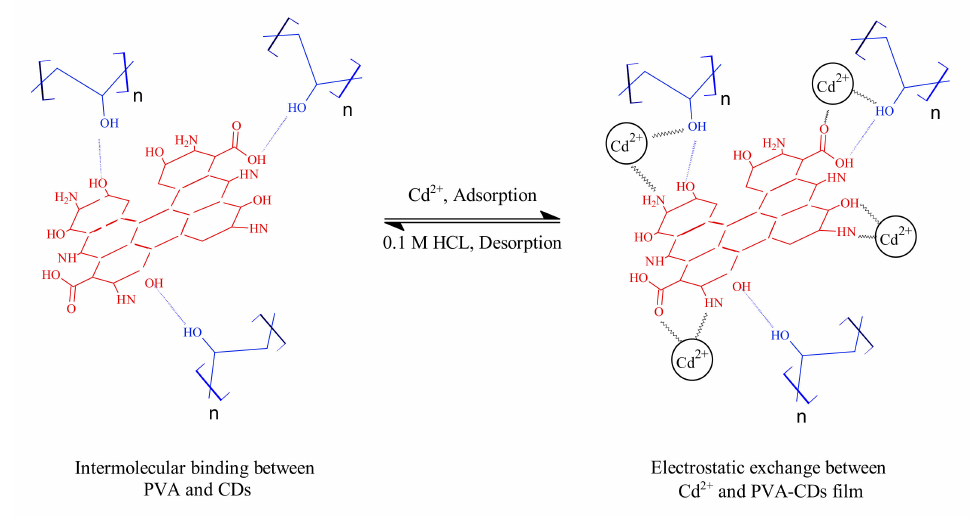
Figure 6. Schematic representation for the adsorption / desorption of Cd 2 + by PVA-CDs nanocomposite.